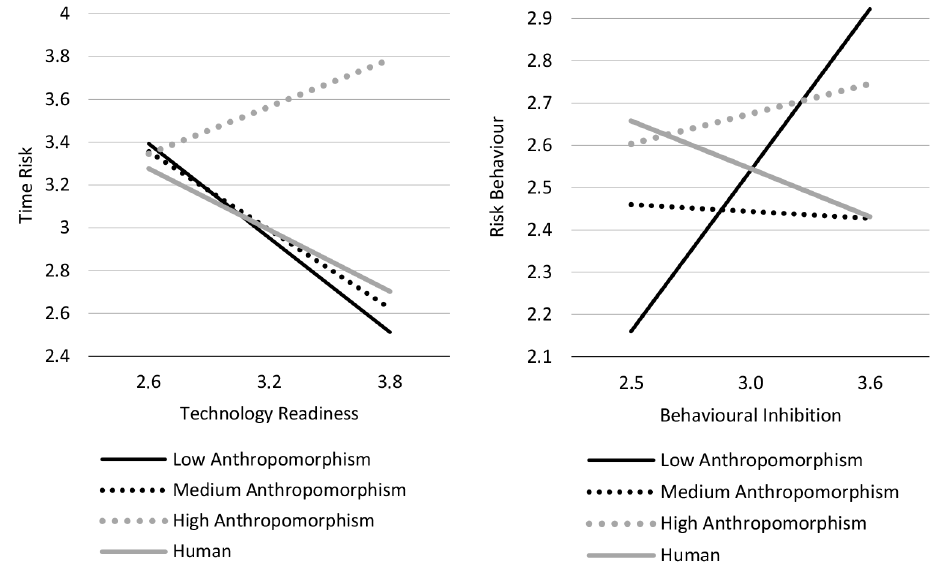
Figure 1. Moderation of the effect of anthropomorphism on (left) time risk perception by technology readiness and on (right) risk behavior by behavioral inhibition